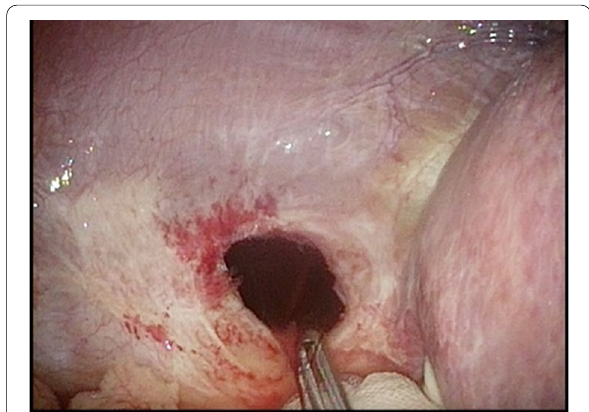
Fig. 4 Hernial orifice. The diameter of the hernia defect was approximately 2 cm. The diaphragmatic tissue around the hernial orifice was not fragile by tactile sensation